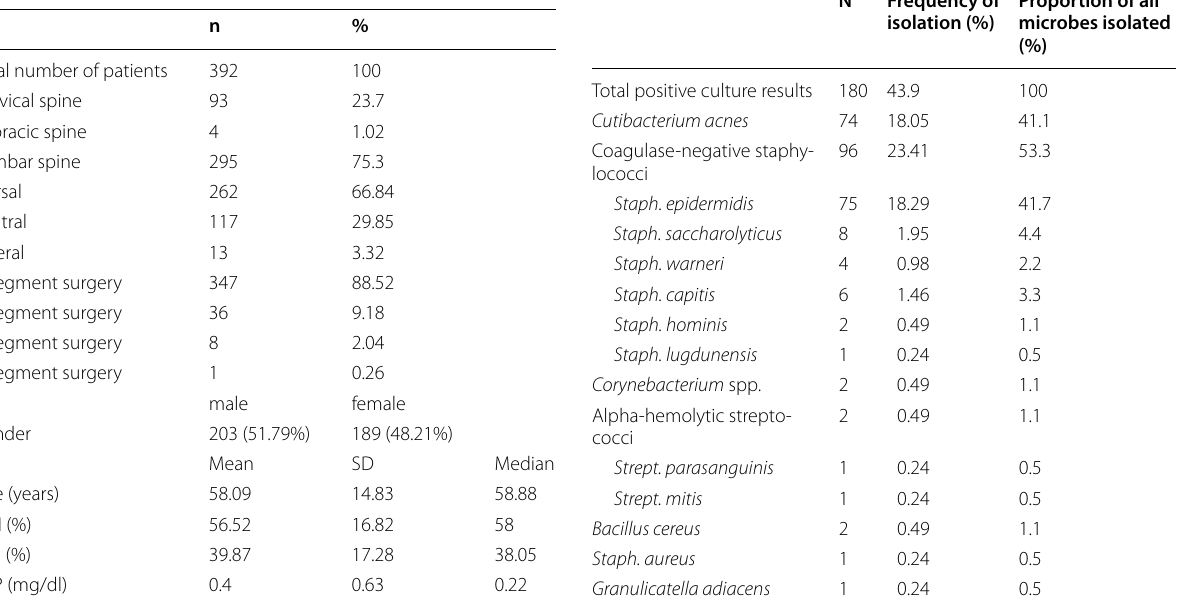
Table 2 Baseline patient characteristics